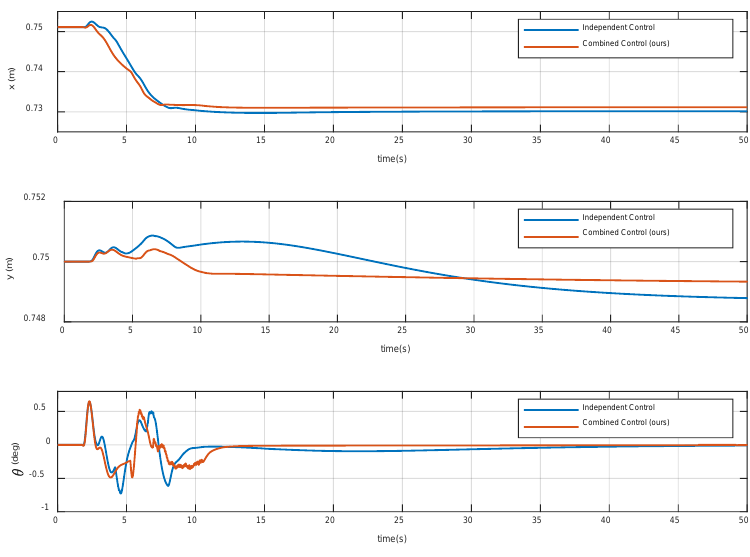
Figure 16. Variation of the base position and attitude.